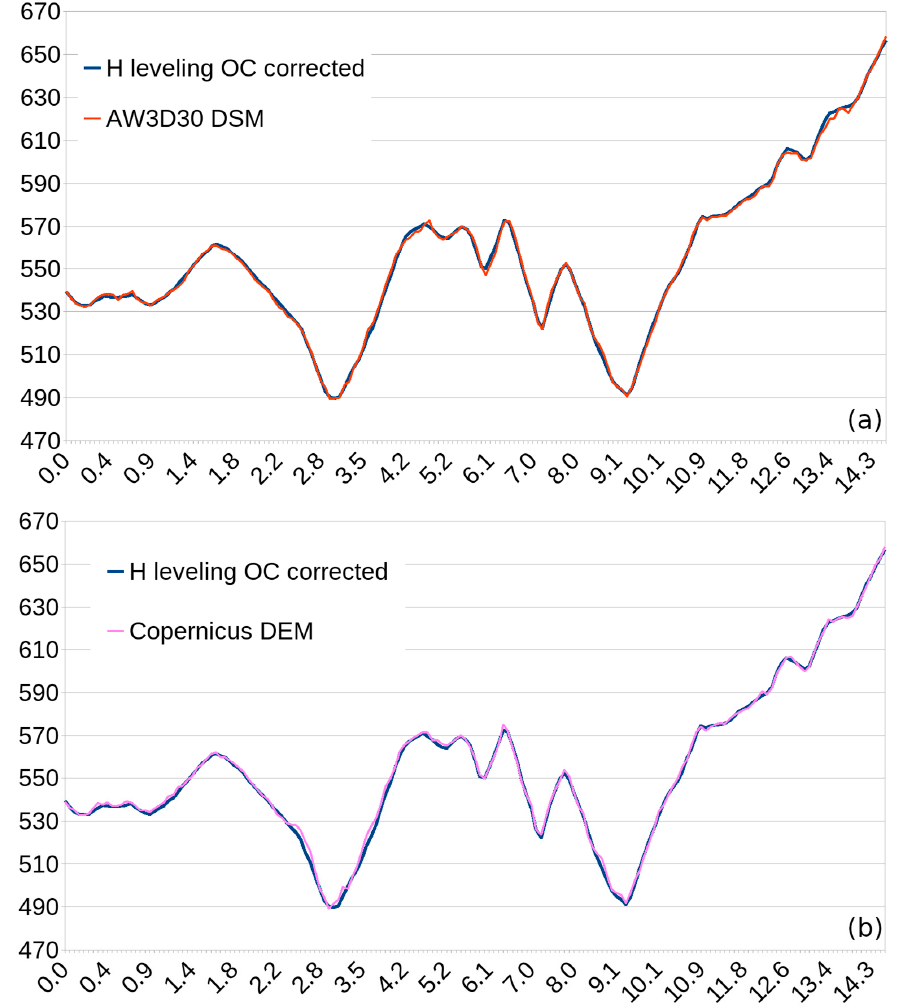
Figure 8. Height values along the traverse in Northern Greece from ( a ) AW3D30 DSM (red line) and leveling and ( b ) Copernicus (pink line) and leveling. ( x ‐ axis: distance in km/ y ‐ axis: height in m).